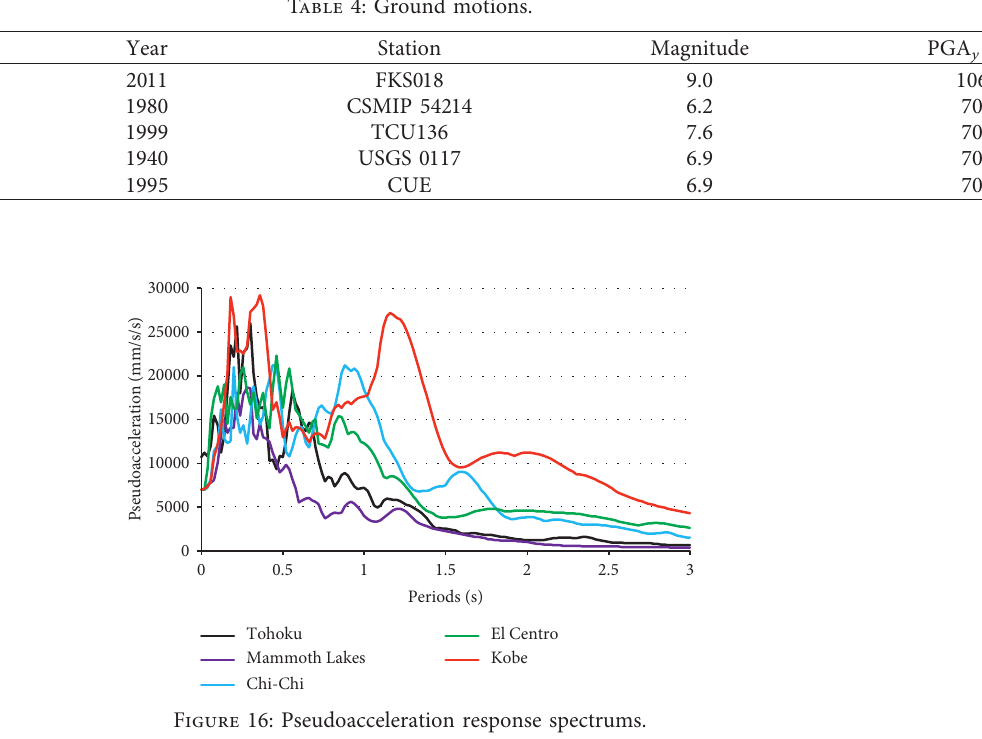
Figure 15: Force displacement of pushover analyses under different axial compression ratio of RC column R (c) R ac � 0.4.